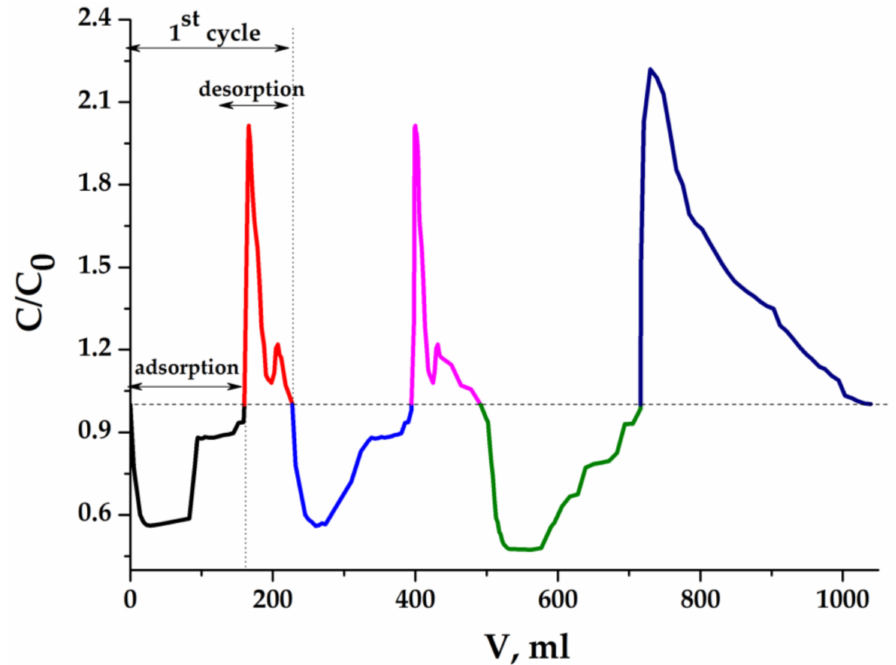
Figure 16. Three successive cycles of membrane capacitive deionization (MCDI) experiments on gap: 0.3 cm; flow rate: 0.75 cm 3 /